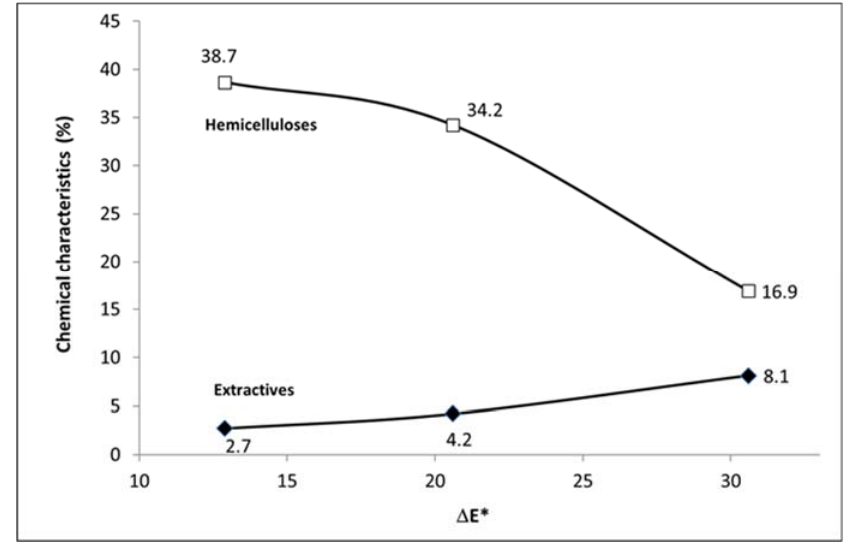
Figure 11. Dependence of Δ E * on the content of hemicelluloses and extractive substances.